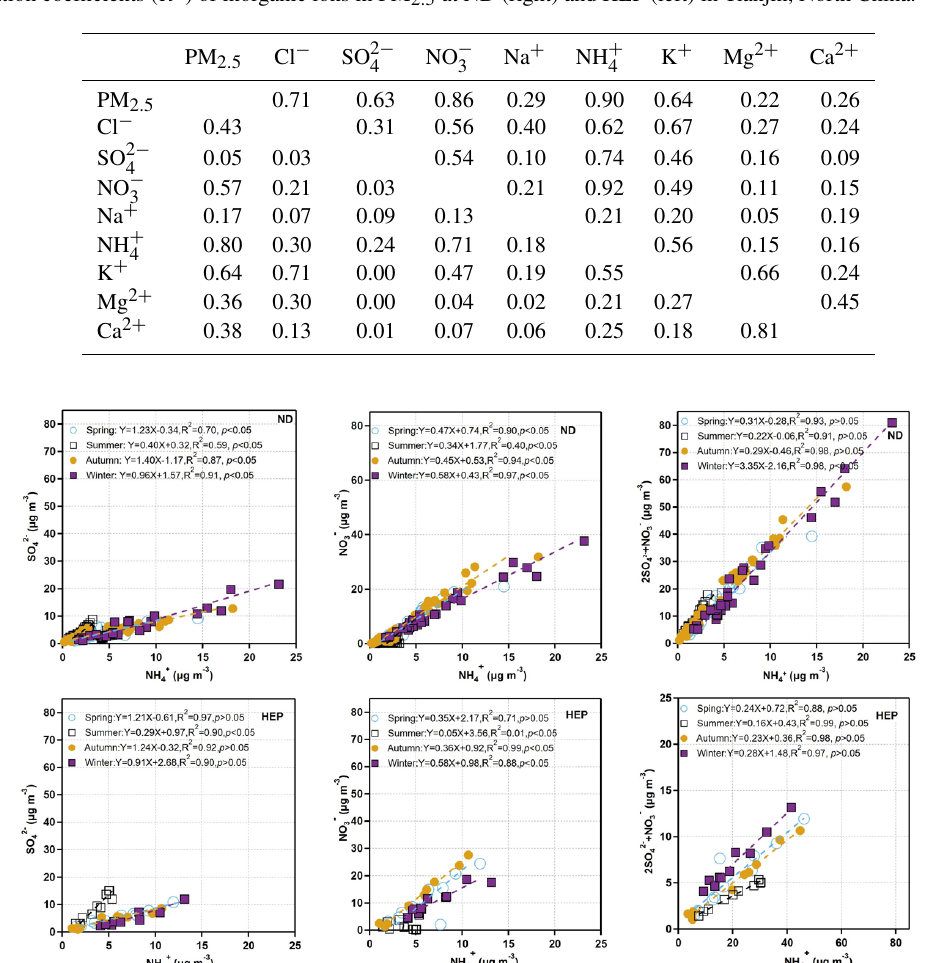
Figure 12. Linear relations between secondary ions in PM 2 . 5 at ND and HEP in Tianjin during the campaign